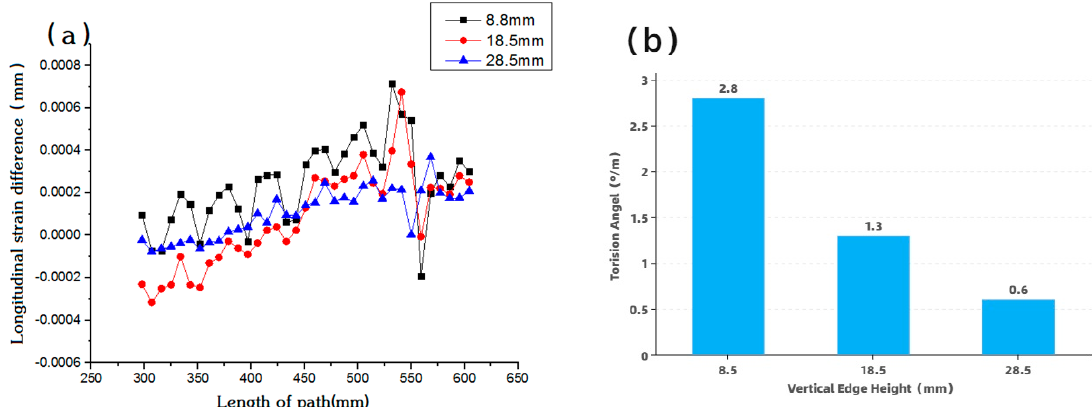
Figure 11. Simulation results of different vertical edge heights. ( a ) Influence of different Vertical edge height on torsion; ( b ) The torsion increases with the height of the vertical edge.